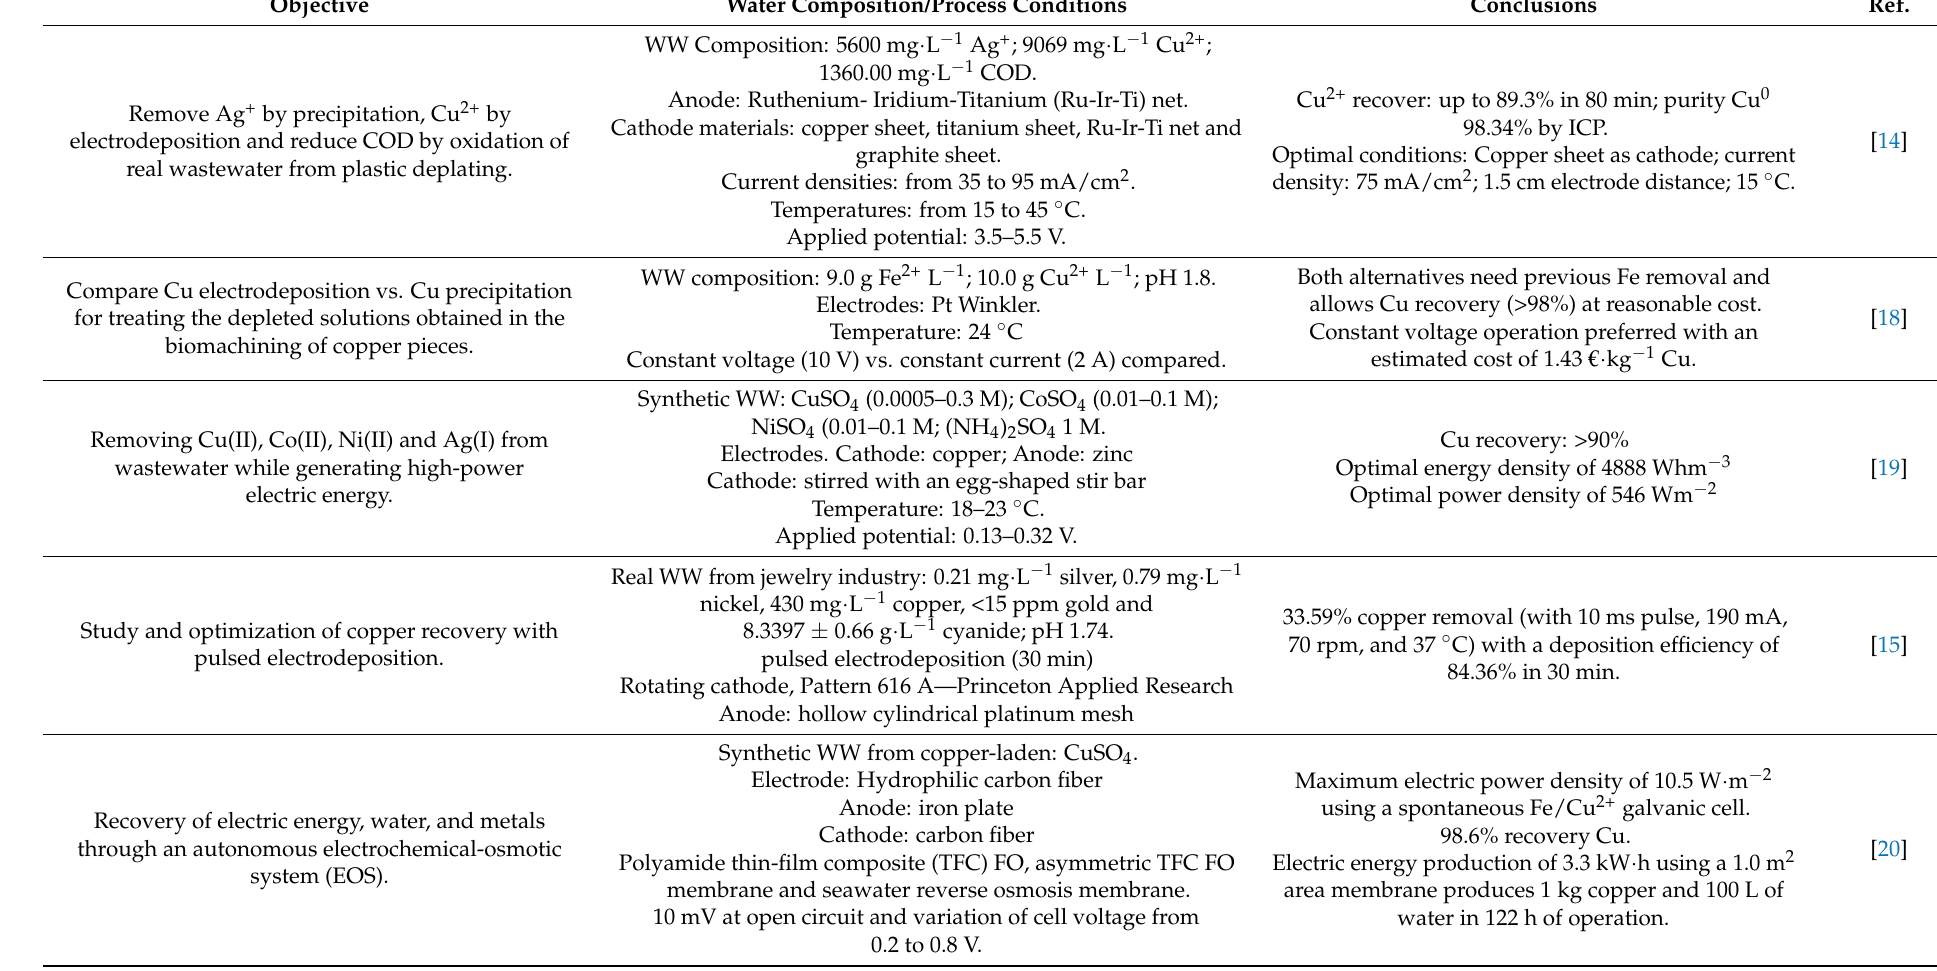
Table 1. Most recent articles published for treatment and reuse of wastewater (WW) by electrodeposition for metal recovery. Objective Water Composition/Process Conditions Conclusions Ref.